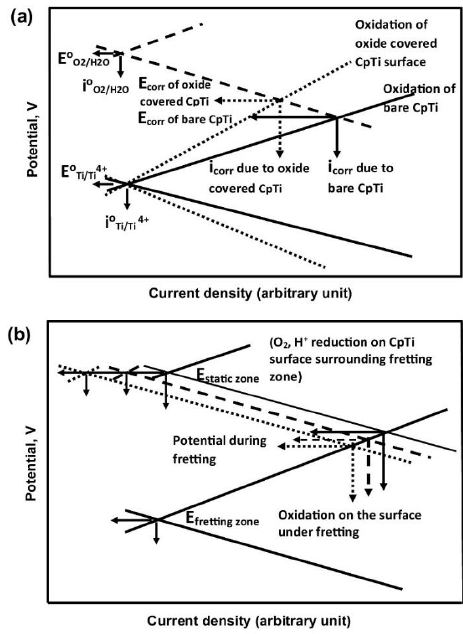
Figure 32. Evans diagrams illustrating the change in potential and current due to ( a ) the oxide covered Ti surface, and ( b ) the increase in fretting area/time. Dashed lines represent the changes occurring as the cathode area decreases with the progress in fretting [346]. Reprinted with permission of Elsevier.